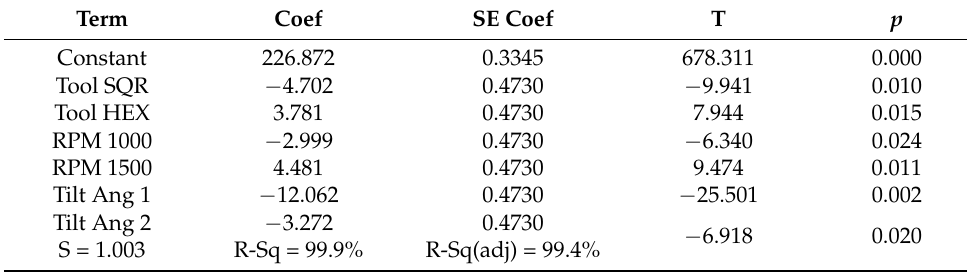
Table 7. Estimated model coefficients for mean.